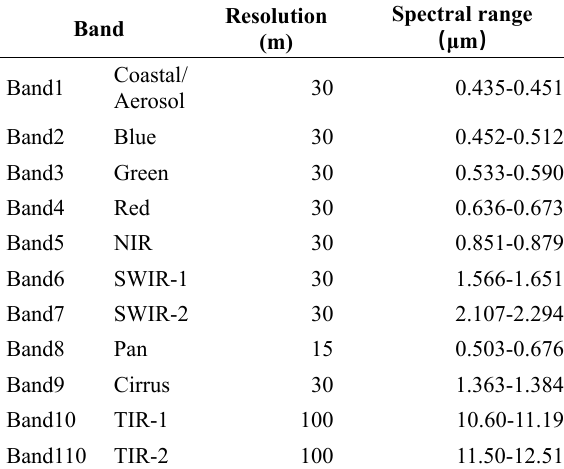
Table 1 . Main parameters for the Landsat8 OLI/TIRS